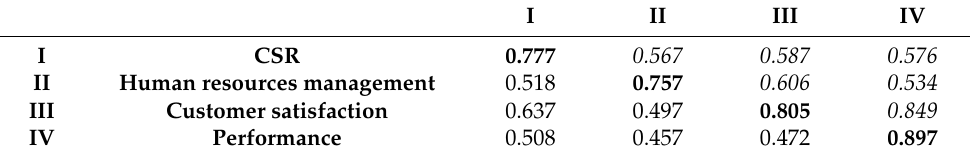
Table 3. Discriminant validity.